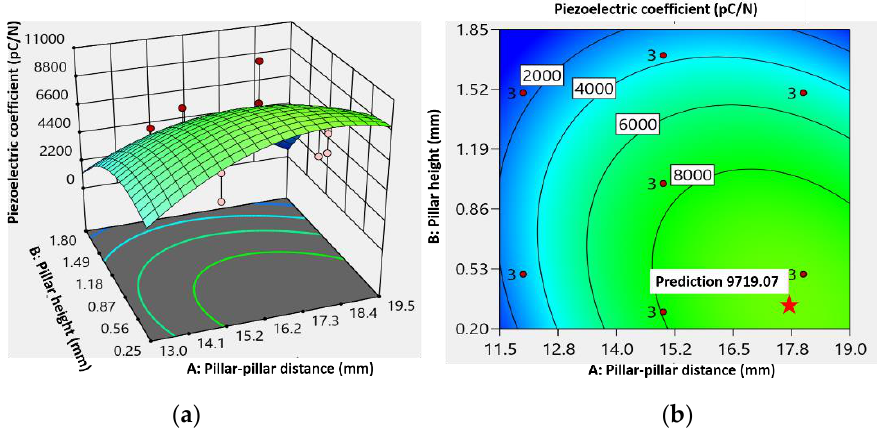
Figure 6. ( a ) Response surface of piezoelectric coefficient corresponding to piezoelectrets with different structure parameters. Red dots in the figure were experimental measurements, and the green surface was the model predicted response surface. ( b ) The 2D projection of the response surface showing the maximized 𝑑 33 and the associated optimal structure parameters (pillar height and pillar – pillar distance). This optimum is indicated by the star on the figure.